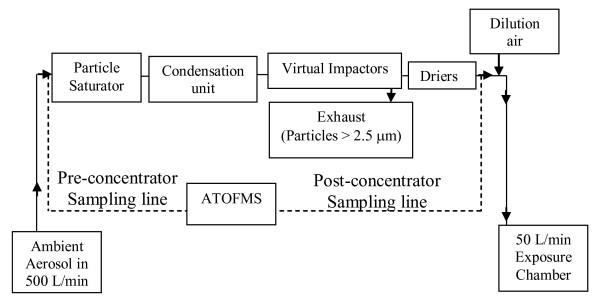
Schematic diagram depicting the operation of the ambient particle concentrator used in this study. The dotted lines illustrate sampling points for the ATOFMS. The ATOFMS was connected to each sampling line in turn for approximaetly 40 minutes.